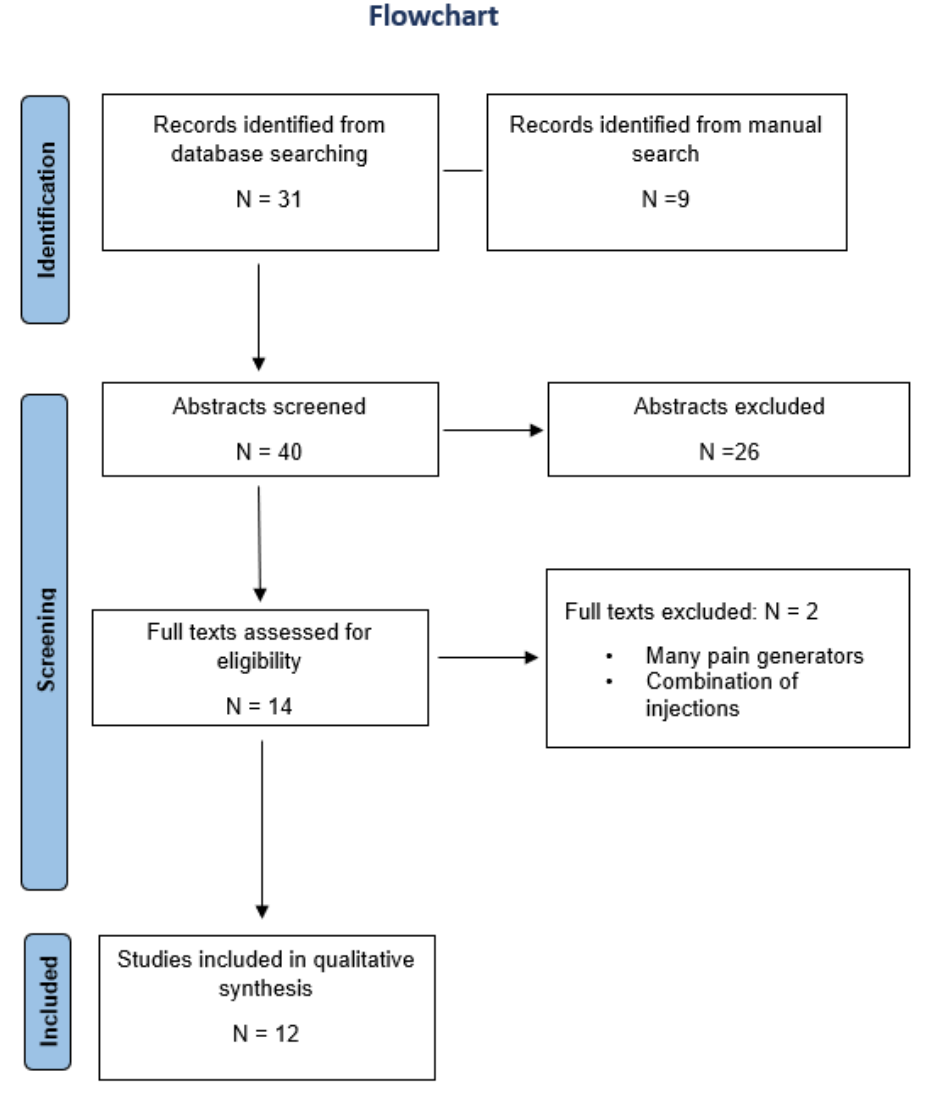
Figure 1. PRISMA 2009 flow diagram.